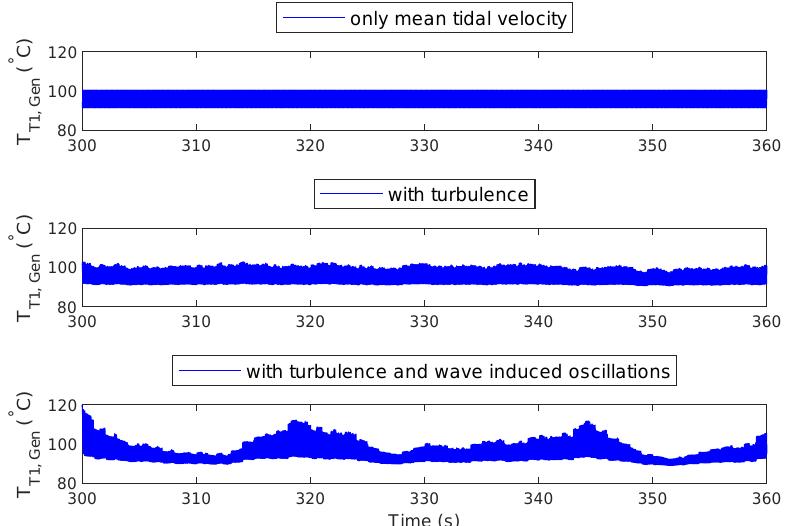
Figure 19. Temperature of the Generator Side Converter insulated gate bipolar transistor (IGBT) (T1) as a function of the fluctuations in the tidal stream